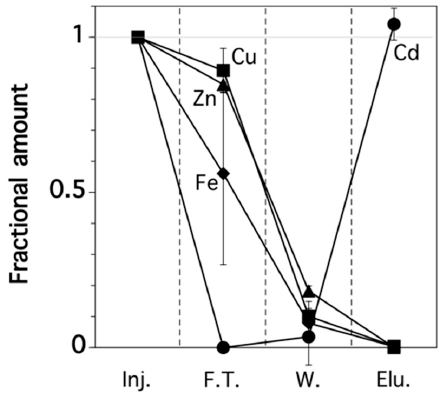
Figure 4. Relative amounts of Cd, Zn, Cu, and Fe from a real rice sample in each column fraction. Inj.: injection; F.T.: flow-through fraction; W.: washout fraction; Elu.: elution fraction. Error bars indicate the standard deviation, which was determined using three replicates.